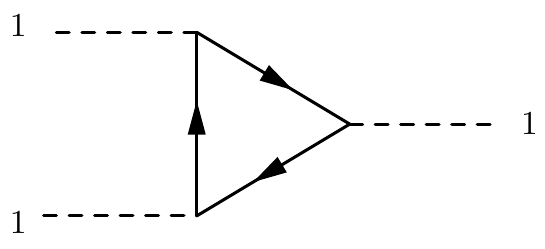
Figure 2 . One loop correction to the three-point correlation